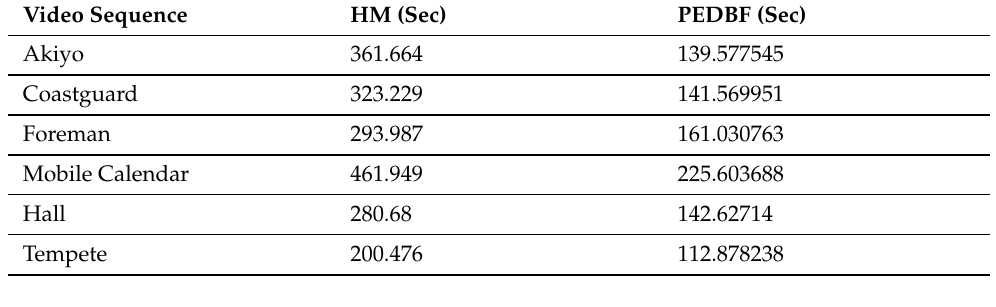
Table 8. Processing time of CIF video sequences with QP = 37.